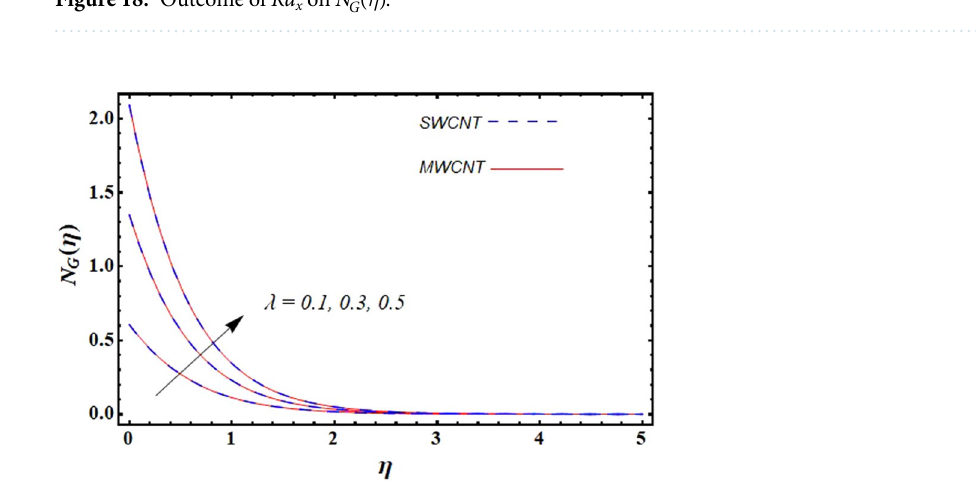
Figure 18. Outcome of Ra x on η N ( )